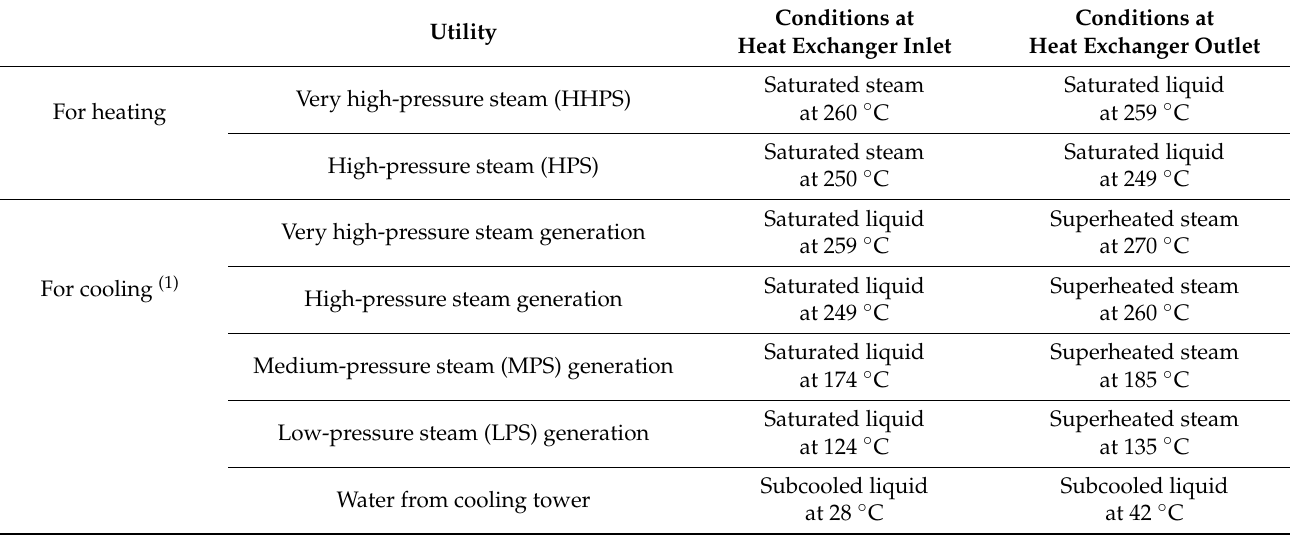
Table 8. Utilities for the heat exchanger